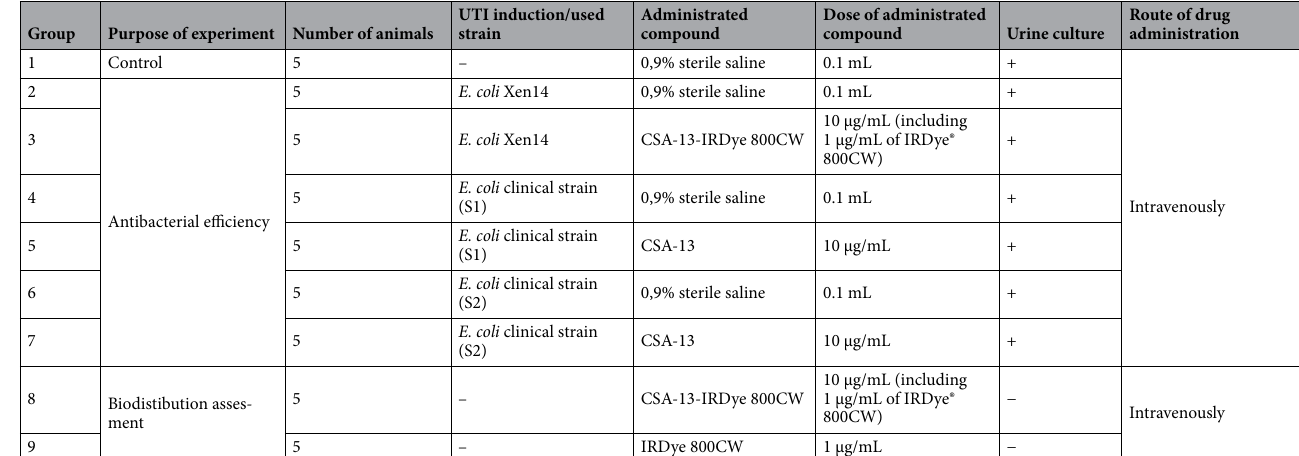
Table 3. Groups of animals used in animal study. Urinary tract infection (Day 0) induction of urinary tract infection by E. coli Xen14 and two clinical strain of E. coli (S1 and S2) administration (n = 5 per group; group 2–7). (Day 1) 24 h after induction, mice were divided into 2 groups: (1) UTI-suffering, untreated animals that obtained intravenously 0.1 mL of 0.9% NaCl (n = 5; group 2, 4, 6), and (2) UTI-suffering animals, treated i.v. with CSA-13-IRDye800CW or CSA-13 at dosage of 5 µg/g of body weight (n = 5 per each group; group 3,5,7). (Day 2) the urine was collected from the animals from 1 to 7 groups at the specified times (0 h, 4 h, 8 h, 12 h and 24 h after treatment) and then were plated on MacConkey agar plates to determine bacterial titers. Part 2: Biodistribution of CSA-13. (Day 0) Mice were injected with 0.1 mL of 0.9% NaCl (n = 15). (Day 1) mice were divided into the following groups: Group 8 and 9 were injected intravenously with CSA-13-IRDye800CW (n = 5; group 8) or unmodified IRDye800CW dye (n = 5; group 9), respectively. (Day 2) Animals from 8 and 9 groups were imaged using the Pearl®Trilogy small animal imaging system (Li-COR, Lincoln, NB, USA) at different times after treatment with CSA-13-IRDye800CW (n = 5; group 8) or unmodified IRDye800CW dye (n = 5; group 9) (0 h, 4 h, 8 h, and 12 h), after that animals from all groups were sacrificed and tissues were